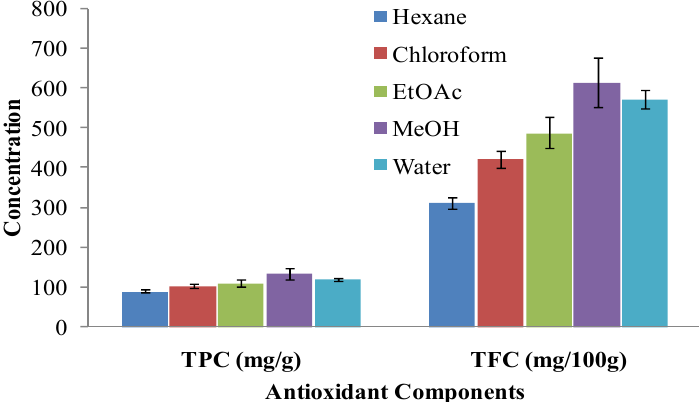
Figure 1. Contents of phenolics and flavonoids in various solvent extracts of Artimisia annua